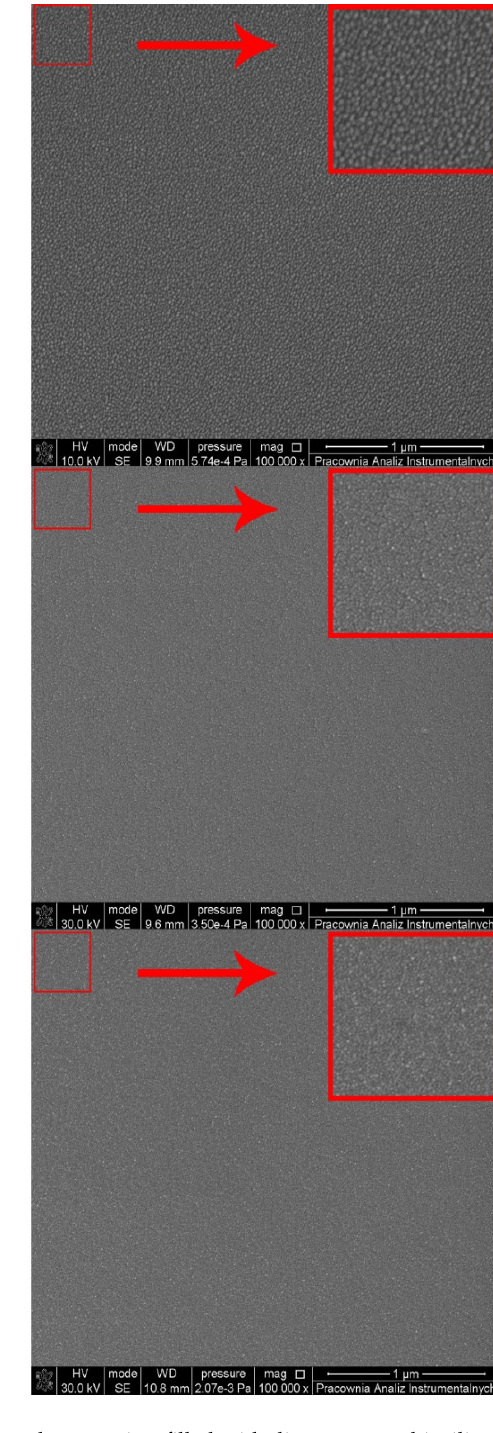
Figure 3. SEM images of elastomer and elastomer based composites filled with diatomaceous biosilica.